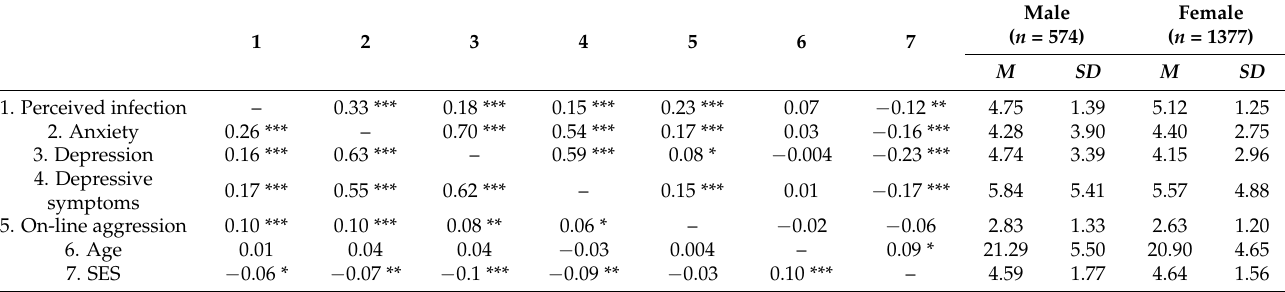
Table 2. Descriptive statistics and correlations among variables.